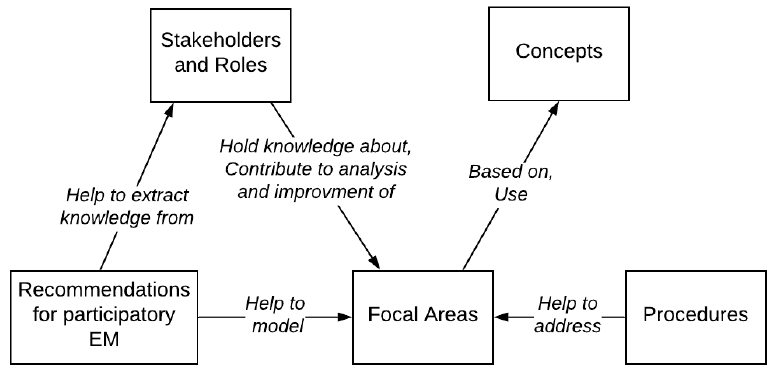
Figure 3. Resulting method – the